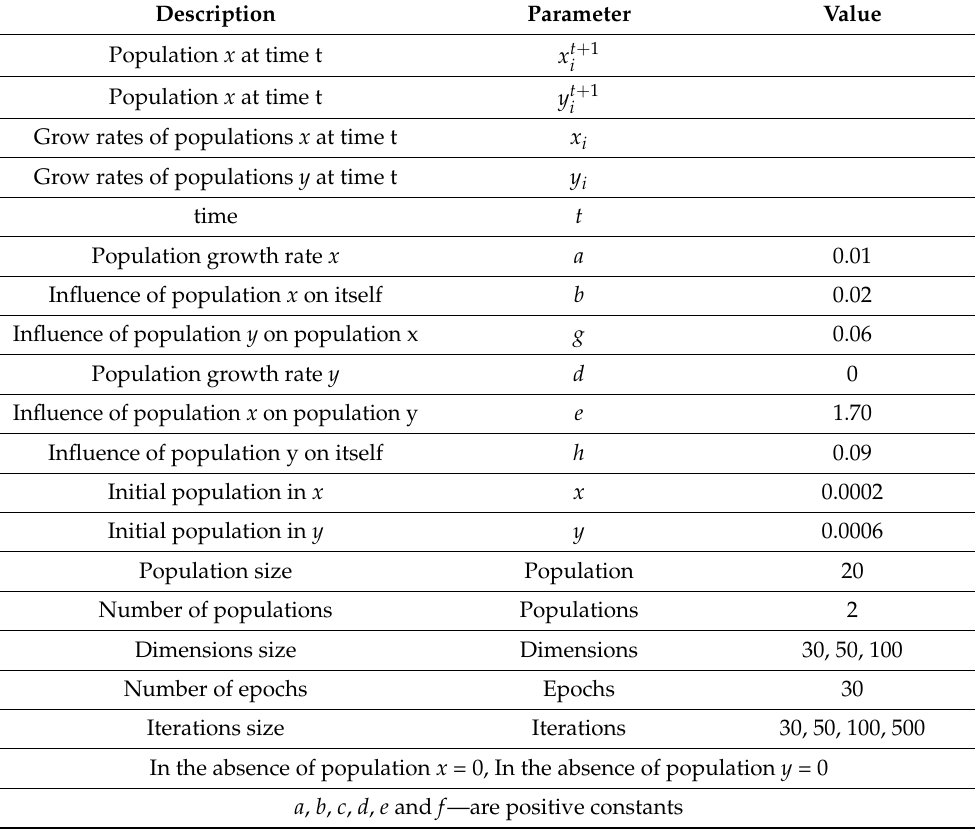
Table 2. DMOA and MTOA Algorithm Parameters. Description